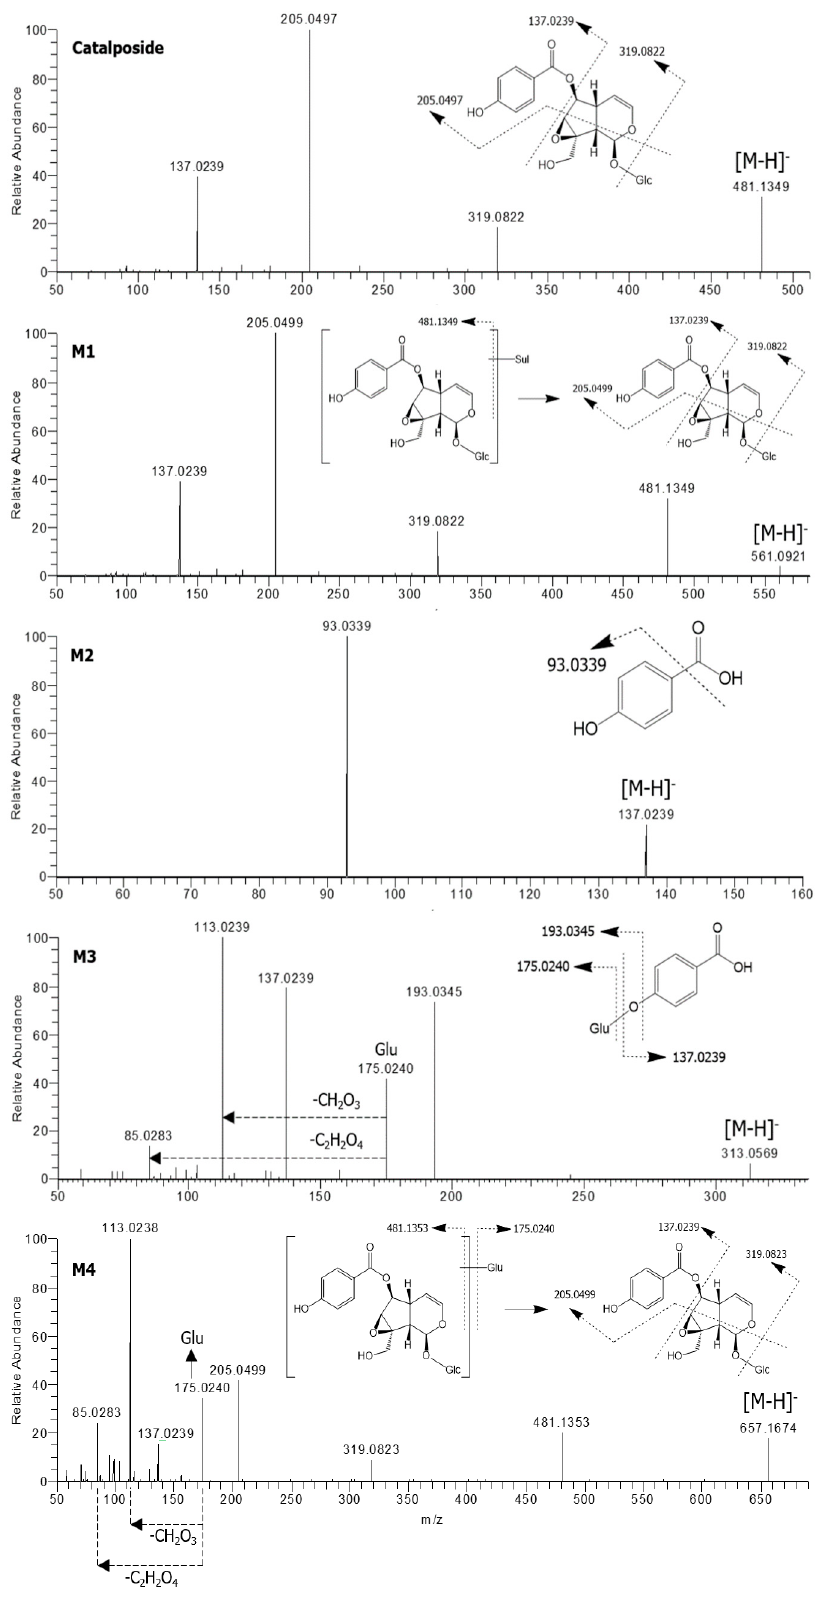
Figure 2. Product scan spectra of catalposide and its four metabolites, M1–M4 obtained via liquid chromatography-high resolution mass spectrometry (LC-HRMS) analysis of reaction mixtures obtained after incubation of catalposide with human intestinal microsomes in the presence of uridine 5’-diphosphoglucuronic acid (UDPGA) or human hepatocytes. Glc: glucose; Glu: glucuronosyl .